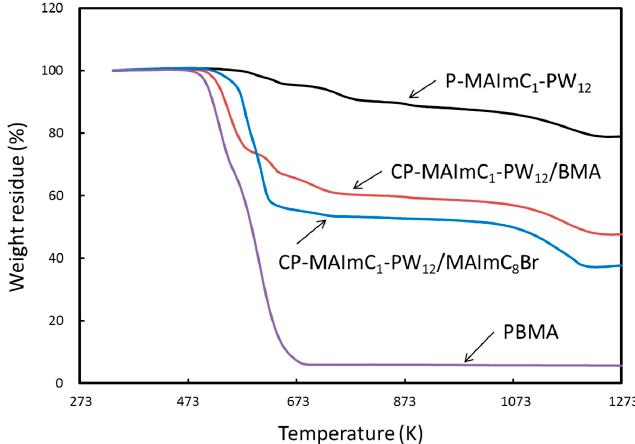
Figure 5. Thermogravimetric curves of MAImC 1 -PW 12 hybrid homo- and copolymers as compared with poly(butyl methacrylate) (PBMA).